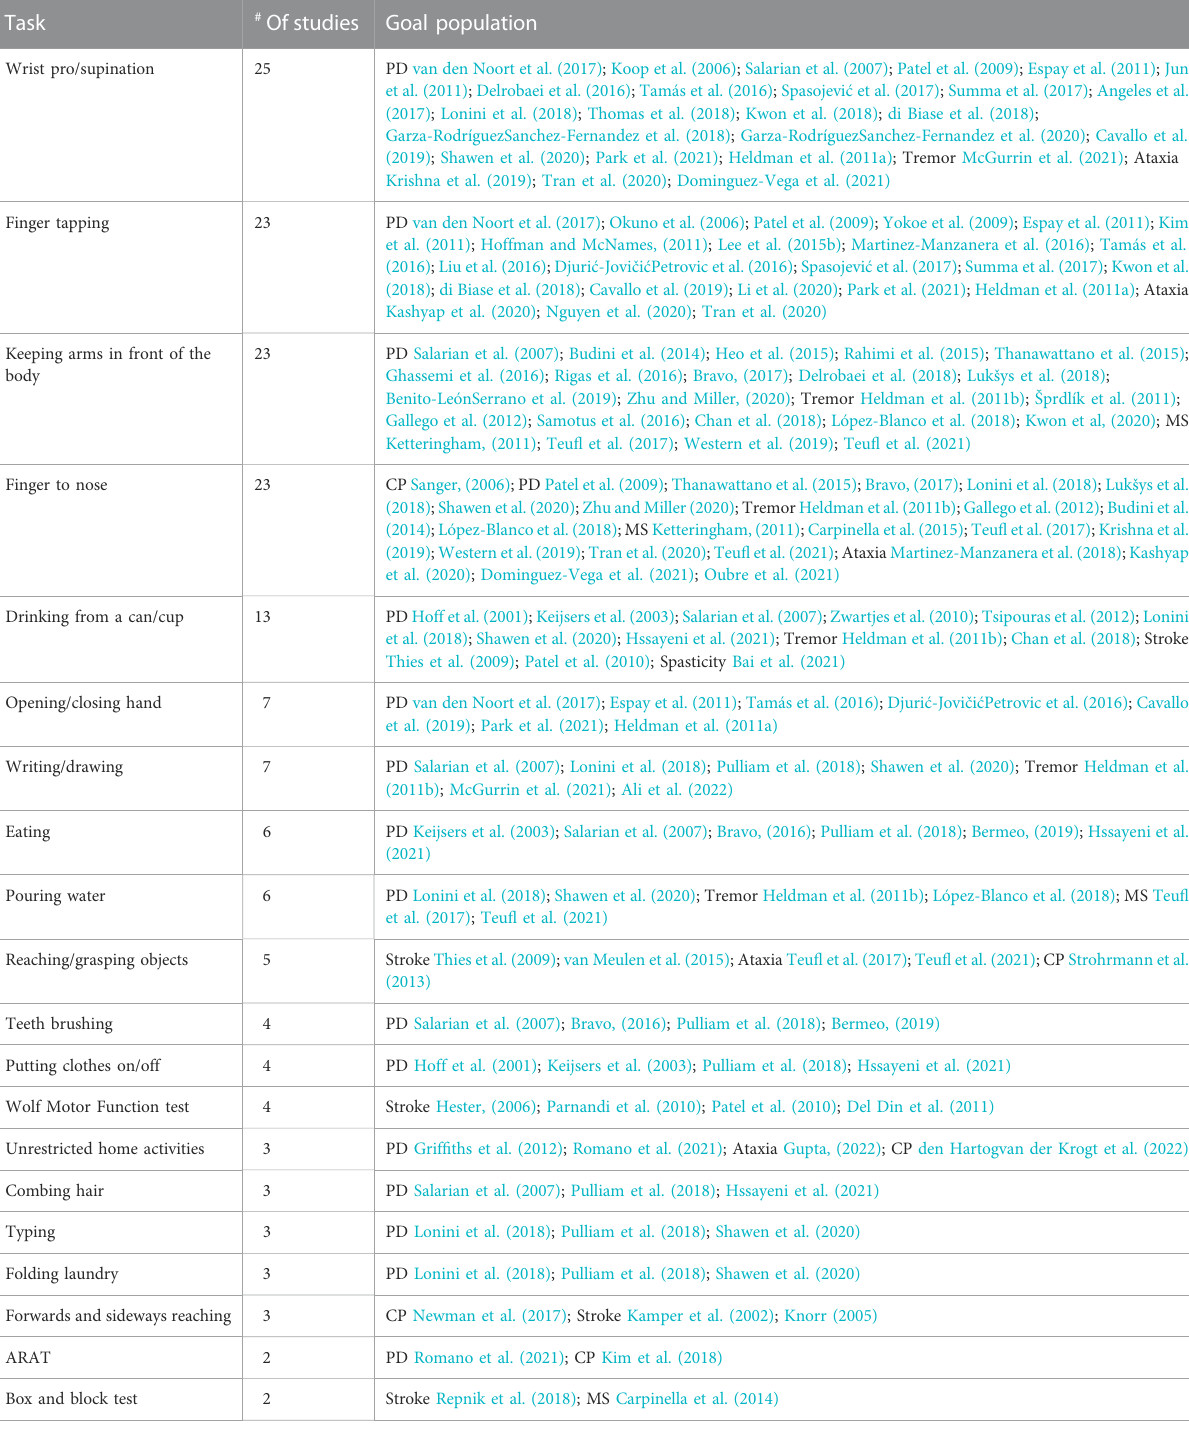
TABLE 1 Tasks included in more than one study, the number of studies and the goal population with associated